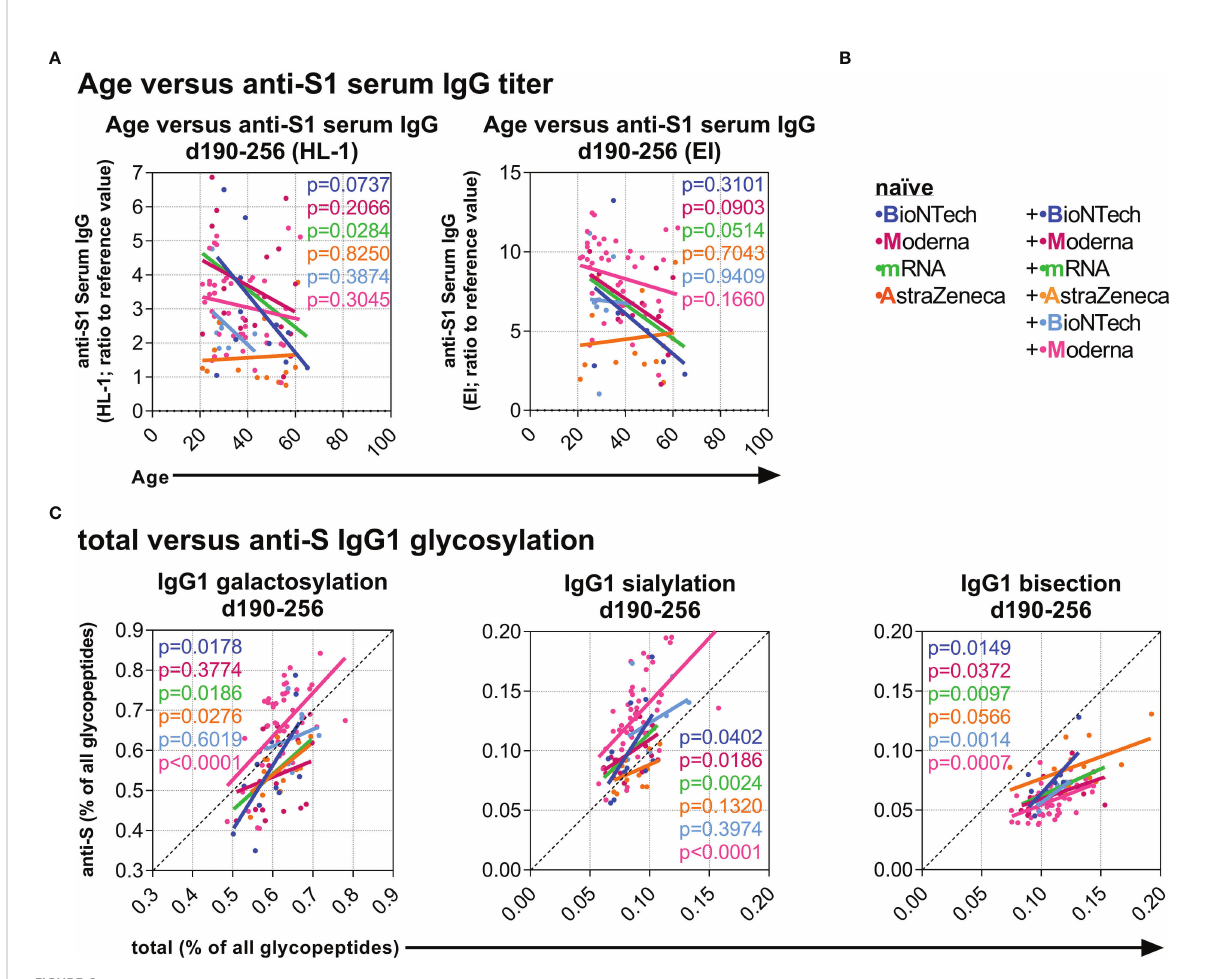
FIGURE 6 Investigation of potential predictive parameters. (A) Negative correlations between age and late anti-S1 IgG titers (samples collected between day (d) 190 and 256 upon fi rst vaccination) (Left: HL-1 ELISA data; Right: EUROIMMUN (EI) ELISA data) of the indicated vaccination groups. (B) Color legend of the six naïve groups; the mRNA group includes both naïve B+B- and M+M-vaccinated individuals. (C) Positive correlations between total and anti-S IgG1 galactosylation, sialylation, and bisection levels from samples collected late between day (d) 190 and